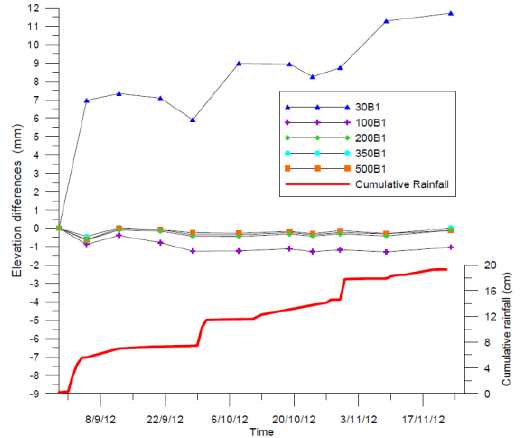
Figure 11. Elevation differences for benchmarks fixed in soil: comparison between the behaviours of neighbour benchmarks founded at different depths, with respect to first epoch.